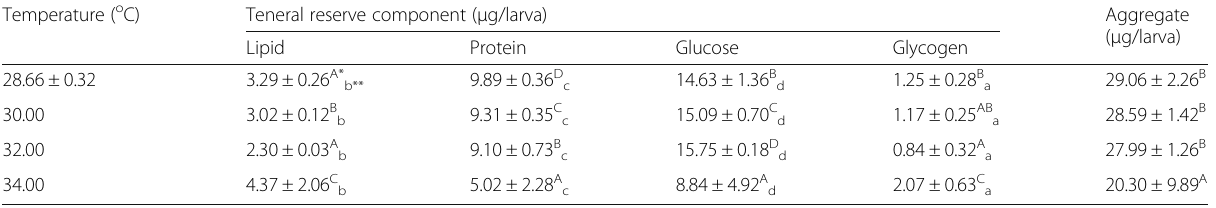
range test following